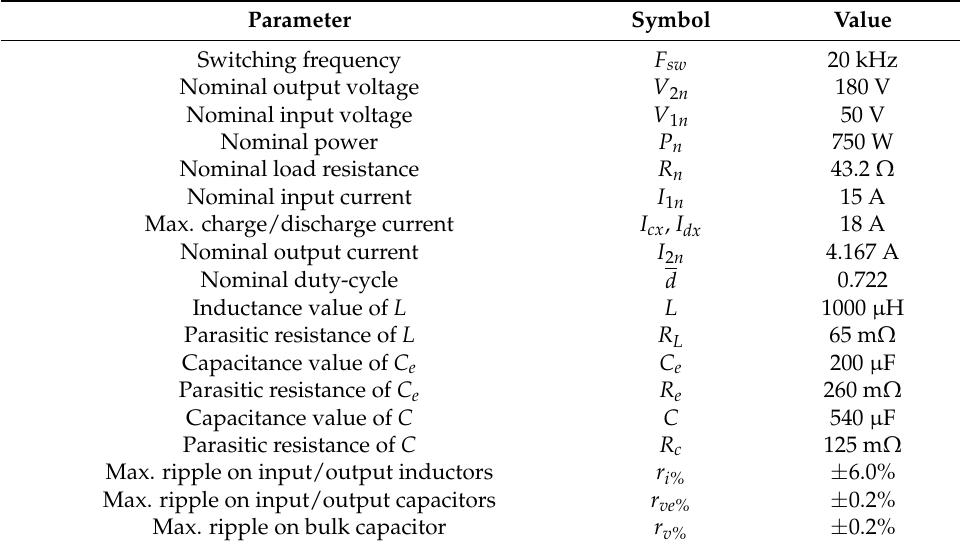
Table 2. Main parameters of the Split-pi